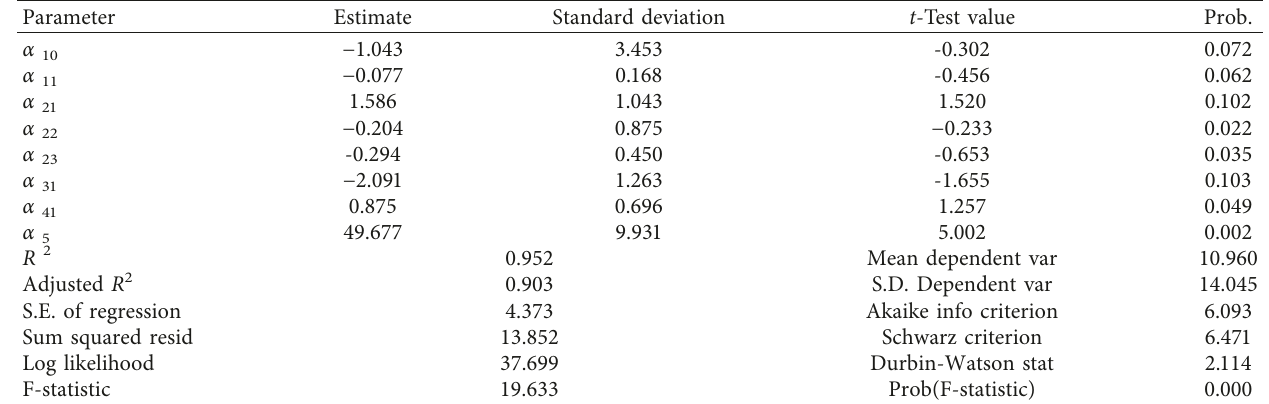
2018 model parameters.